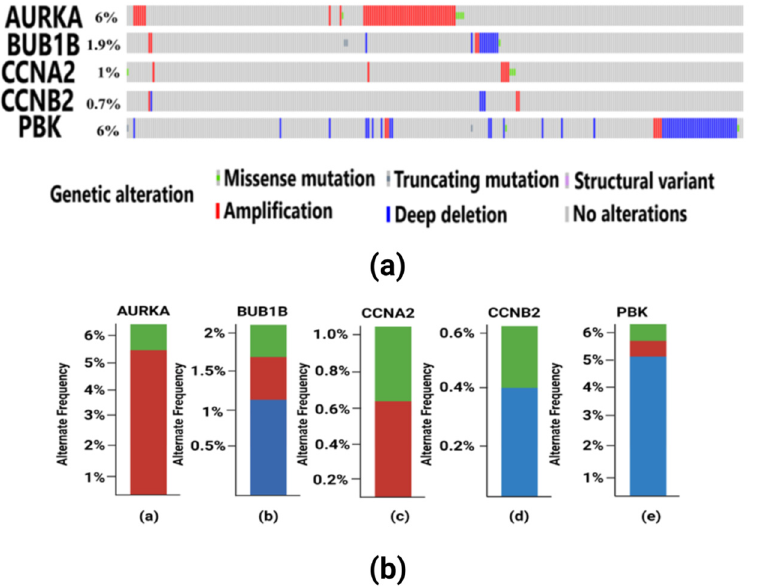
Figure 8. ( a ) Visualization of genetic alterations of hub genes in breast cancer using OncoPrint. Green color in the bar plot represents mutation, red color represents amplification, and blue color represents deep deletion in the cancer patient samples from TCGA. In this figure, AURKA have 6% genetic alteration having missense mutation in 5 TCGA patient samples and amplification in other samples. BUB1B have 1.9% genetic alterations which include missense and truncating mutations, amplification and deep deletion in some samples. CCNA2 have 1% genetic alterations having missense and amplification. CCNB2 consists of 0.7% alterations mainly consisting of amplification and deep deletion. PBK gene has 6% alterations having truncating and missense mutations, amplification and deep deletion in the patient samples. ( b ) Frequency of genetic alterations in hub genes in breast cancer. Red color indicates amplification, green color indicates mutations and blue color indicates deep deletion. (a) The AURKA gene has a more frequent occurrence of amplification in 5% of the samples and less frequent mutations in only 1% of the samples. (b) The BUB1B gene has more frequent deep deletion in 1% of the samples, which is followed by less frequent amplification and mutation each occurring in only 0.5% of the samples. (c) The CCNA2 gene has a higher frequency of amplification in 0.6% of the samples and mutations in 0.4% of the samples. (d) The CCNB2 gene has deep deletion having frequent occurrence in 0.4% of the samples and less frequency of occurrence of amplification in 0.2% of the patient samples. (e) The PBK gene has more genetic alterations due to deep deletion in 5% of the samples, which is followed by amplification in 0.8% of the samples and mutation in 0.2% of the samples, respectively.